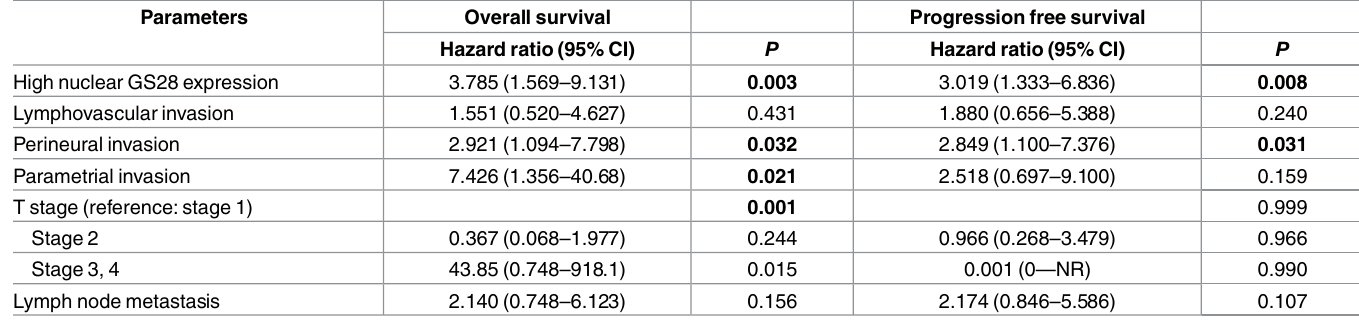
Table 3. Multivariate Cox regression analysisfor overall survivaland progression-free survivalin cervicalcancerpatients(N = 177).